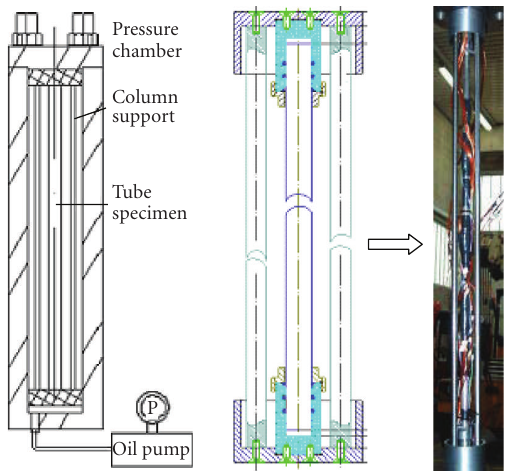
Figure 8: Buckling test machine and specimen’s support.